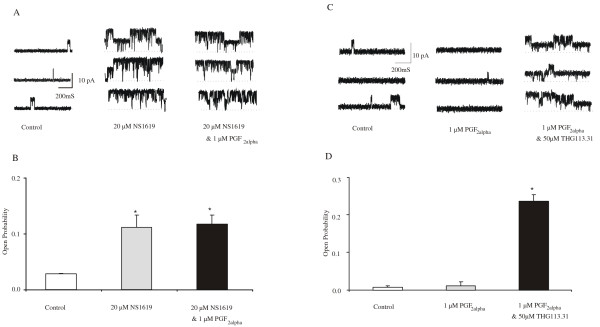
PGF2α has no effect on BKCa channel activity. A Representative recordings from the same membrane patch (+40mV) in the cell-attached configuration after addition of 20 μM NS1619 and subsequent addition of 1 μM PGF2α. PGF2α did not reverse NS1619-stimulated channel activity. B Each bar represents the average channel open probability obtained from cell attached patches (n = 4; +40 mV) before and 15 min after each addition (n = 4). *Significant increase in channel activity compared to control. C & D THG113.31 activates the BKCa channel independently of the FP receptor. Representative recordings from the same membrane patch (+40mV) in the cell-attached configuration before and after addition of 1 μM PGF2α and subsequent addition of 10 μM THG113.31. Each bar represents the average channel open probability obtained from cell attached patches (n = 3; +40 mV) before and 15 min after each addition (n = 3). *Significant increase in channel activity compared to control.